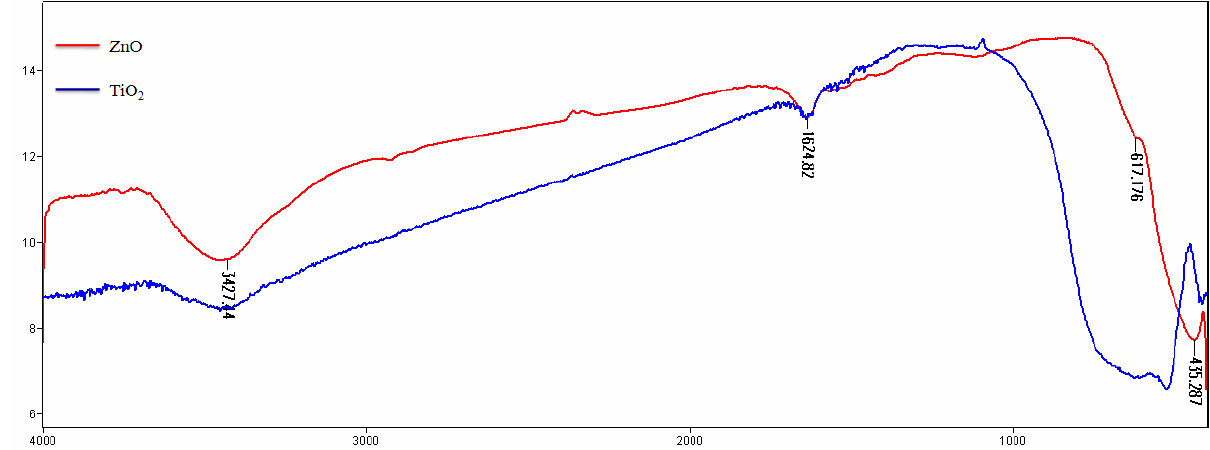
Fig. 2. IR spectra of TiO